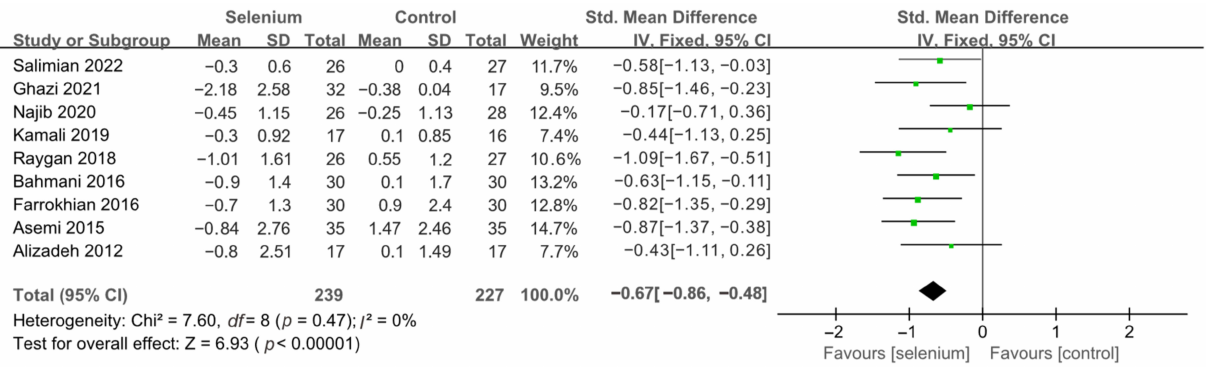
Figure 7. Forest plot of HOMA-IR after excluding Faghihi 2014